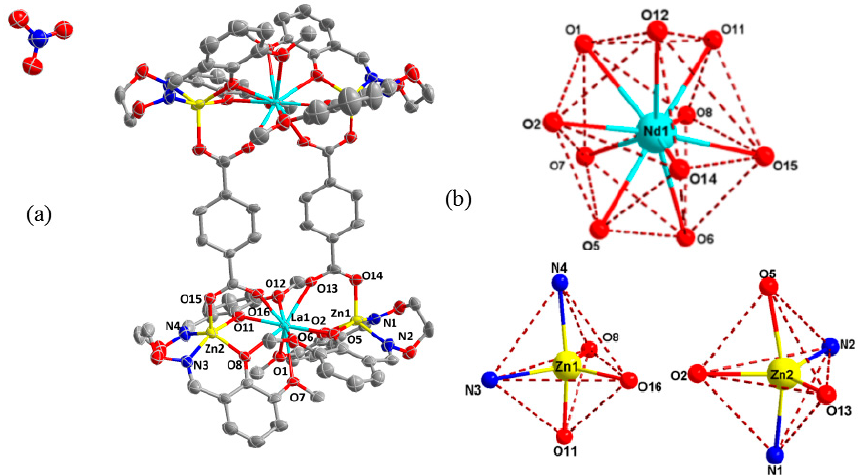
Figure 3. ( a ) Crystal structure of the Zn(II)-La(III) coordination compound (hydrogen atoms are omitted in structure). ( b ) Coordination polyhedra for metal atoms of the Zn(II)-La(III) coordination compound.